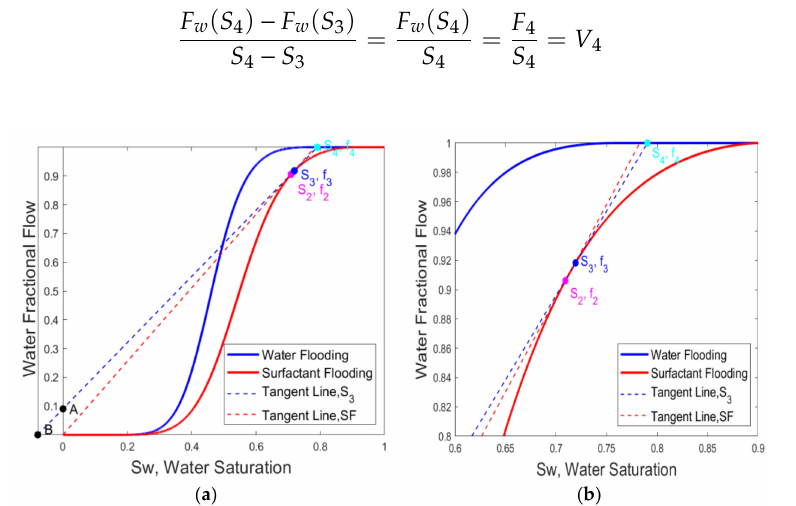
Figure 13. ( a ) Determination of the shock front during surfactant slug injection; ( b ) Magnification of figure ( a ) for determining shock front location, t d , slug = 0.30 PV, t d , total = 3.32